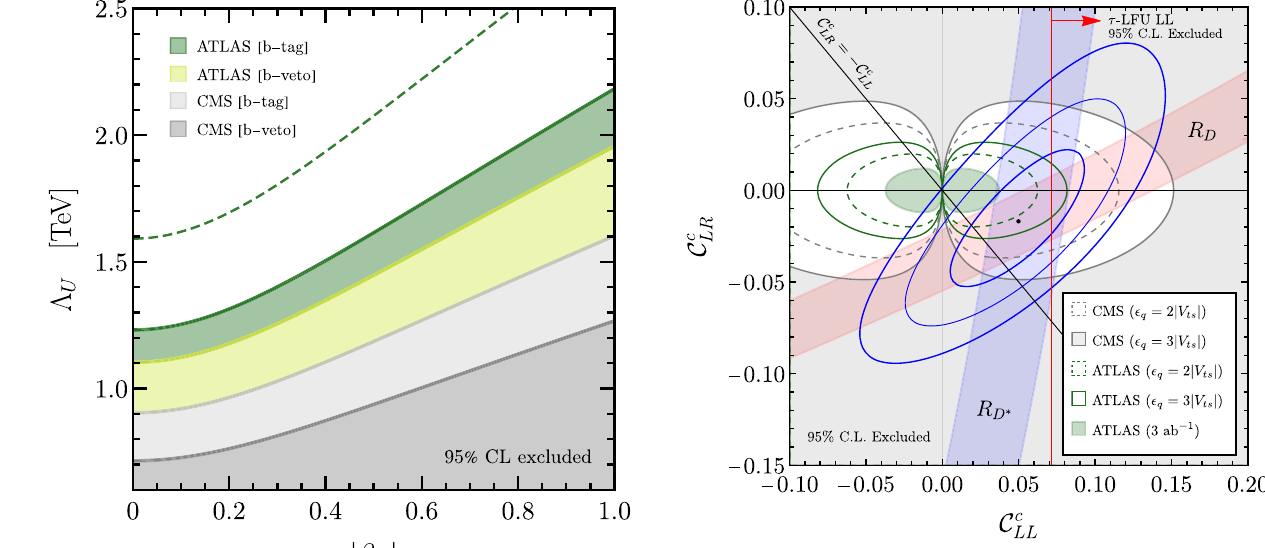
Fig. 3 High- p T constraints superimposed on the low-energy fit. The red and blue bands represent the (cid:13)χ 2 = 1 regions preferred by R D and R D ∗ . The blue lines correspond to the 1 σ , 2 σ , and 3 σ contours of the combined low-energy fit including all b → c observables (dot = best fit point). The high- p T exclusion limits derived from the b -tag channel of the CMS [36] (ATLAS [39]) search are given by regions outside of the gray (green) lines. On the other hand, the region inside the innermost dotted curve is our projection for the allowed parameter space from high- p T searches (in absence of a signal) with a luminosity of 3ab − 1 . Finally, the region to the right of the red line is excluded by τ -LFU tests assuming leading log running of C 33 ττ . See text for more LL